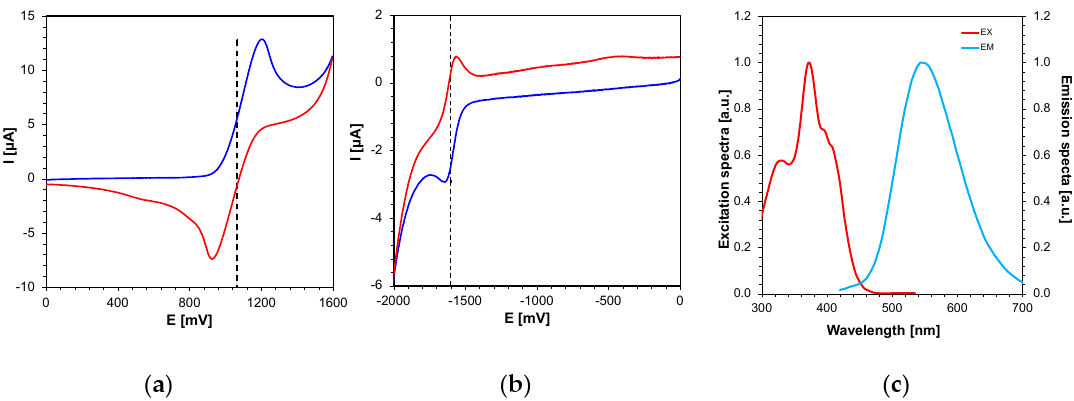
Figure 10. Cyclic voltammogram of the ( a ) T1 oxidation, ( b ) T1 reduction in CHCl 3 (with 0.1 M solution of tetrabutylammonium hexafluorophosphate electrolyte and Ag/AgCl as reference electrode, scan rate 100 mV/s). ( c ) Normalized excitation and emission spectra for T1 in CHCl 3 . Table 7. Electrochemical and thermodynamic properties of sensitizers and their interaction with iodonium salt (IOD) and sulfonium salt (TAS).